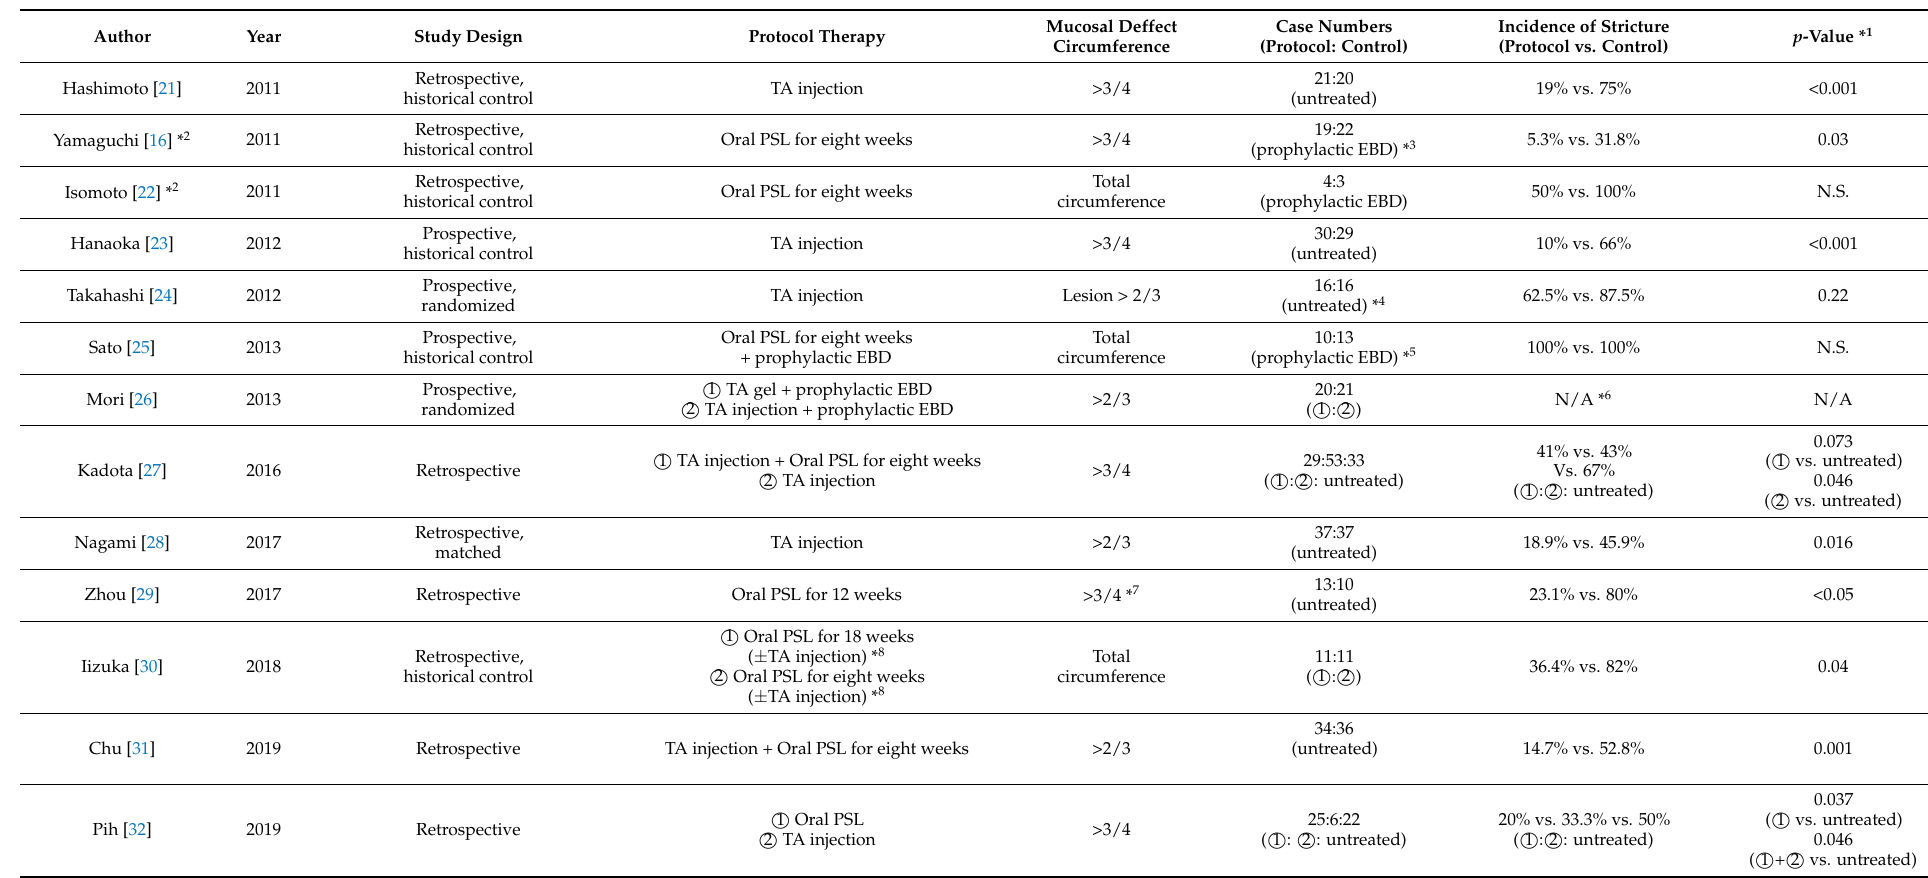
Table 2. Comparative studies of steroid therapy in the prevention of stricture after endoscopic submucosal dissection for esophageal squamous cell carcinoma, mainly compared with no therapy or prophylactic endoscopic balloon